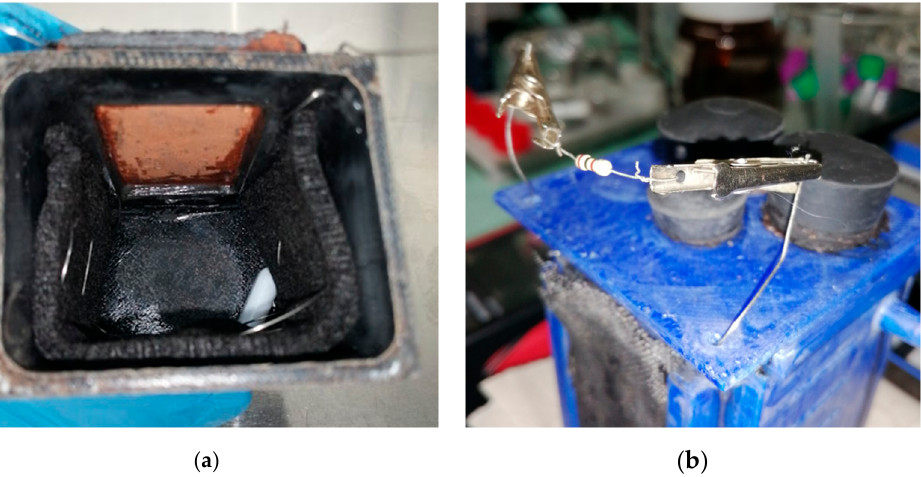
Figure 1. MFC assembly: ( a ) anode and cathode (internal view); ( b ) closed-circuit resistance connection.